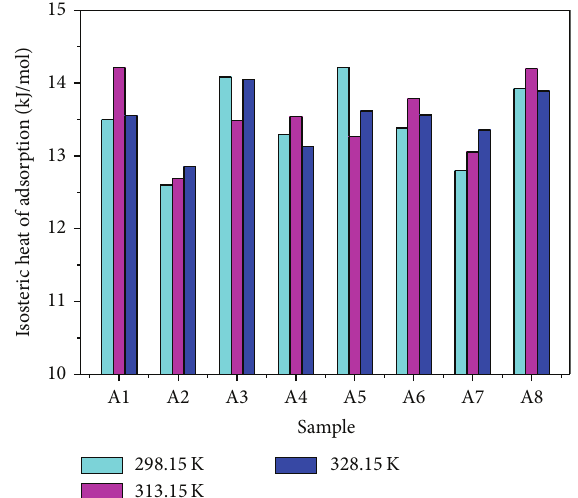
Figure 8: Isosteric heat of methane adsorption on the studied coals.